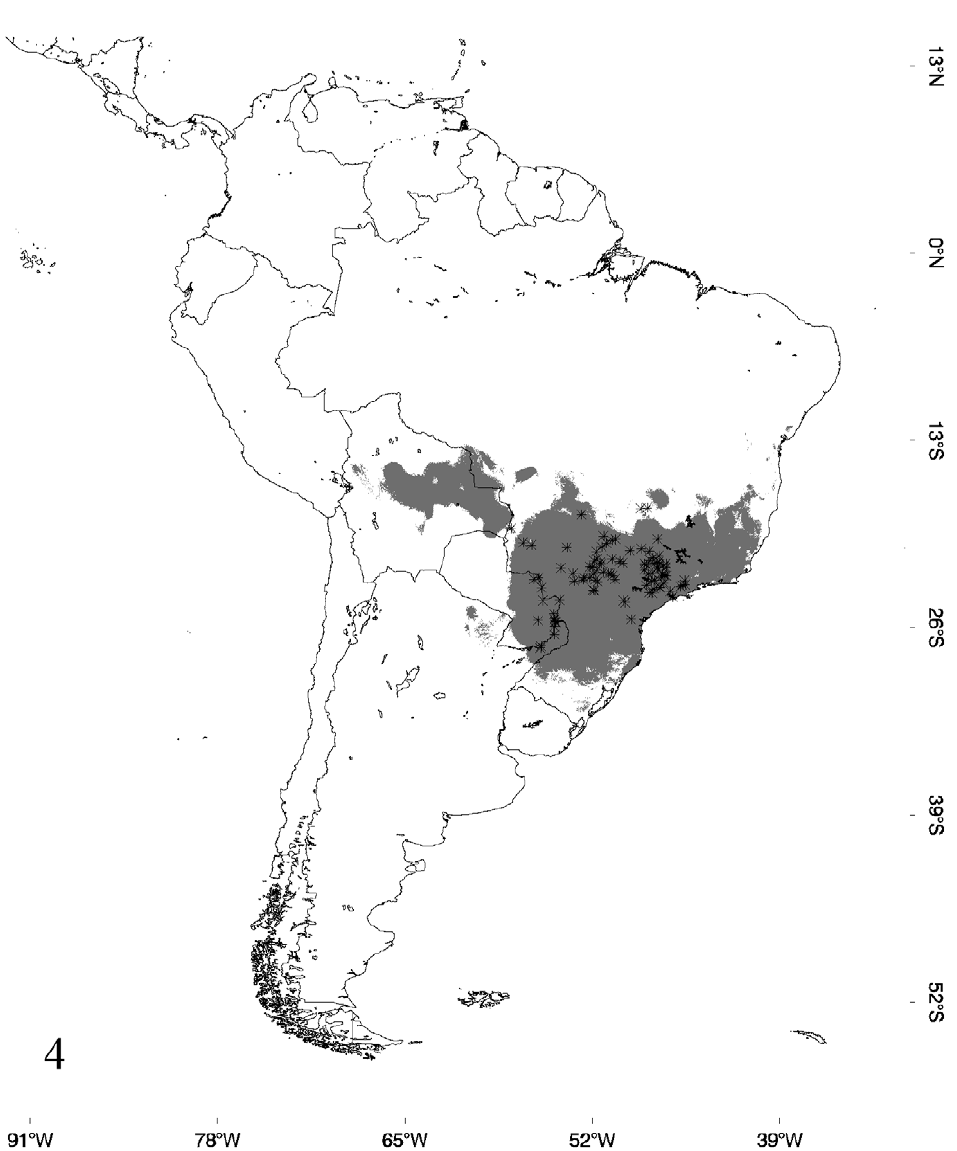
Figure 4. Occurrence probability map for Epicratescenchria , determined by its respective model and points of occurrence.